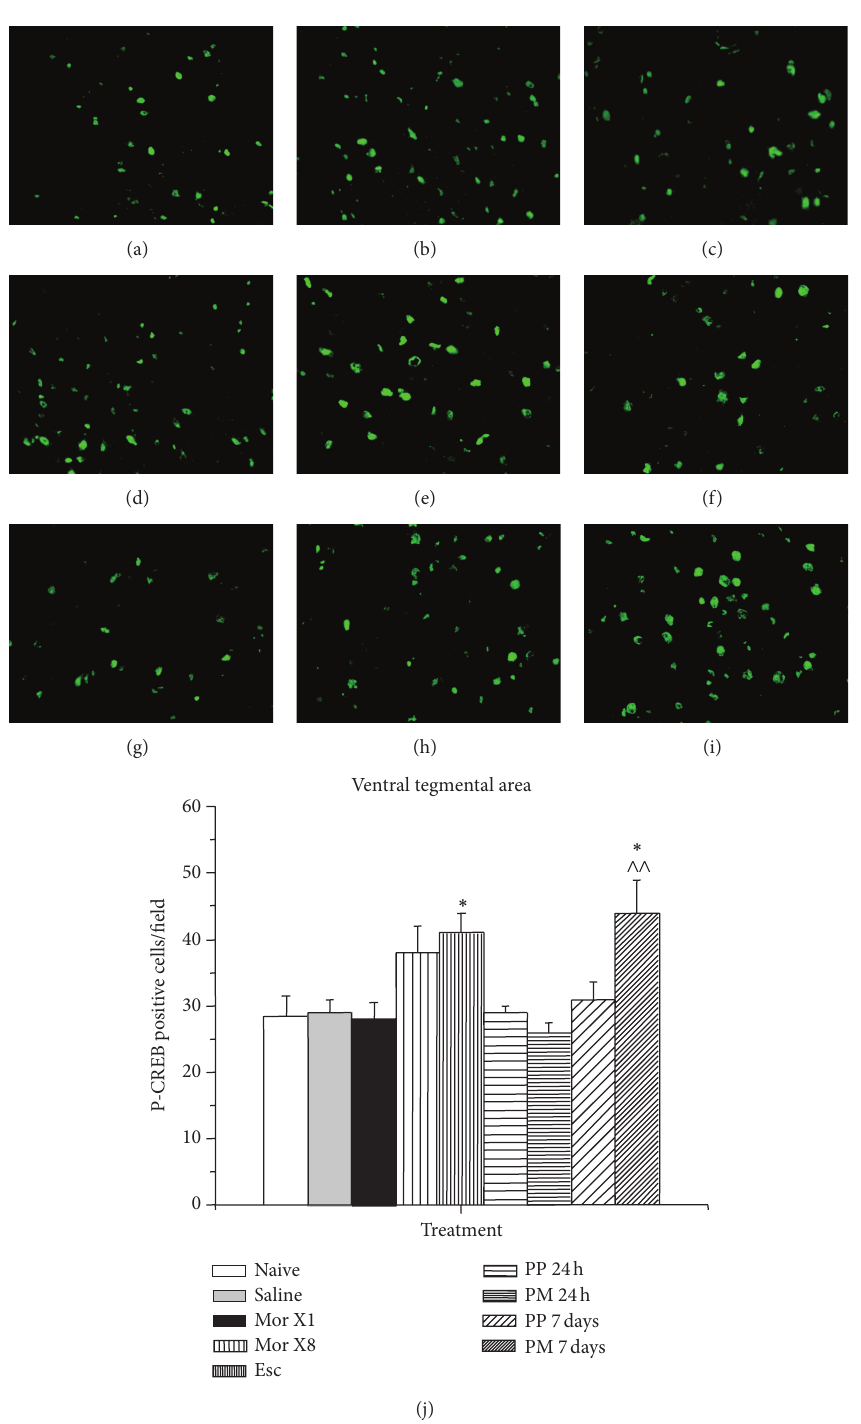
Figure 4: Changes in P-CREB staining in the VTA following different morphine treatments ((a) group 1, na¨ıve; (b) group 2, saline; (c) group 3, MorX1; (d) group 5, MorX8; (e) group 6, Esc; (f) group 7, PP24h; (g) group 8, PM24h; (h) group 9, PP7d; (i) group 10 PM7d) as determined by immunofluorescence (200X). Quantification of P-CREB (j). See Table 1 for details on the morphine treatment paradigm. 𝑁 = 6 – 9 per treatment. ∗ 𝑃 < 0.005 versus saline injection, ∗∗ 𝑃 < 0.0001 versus saline injection, ∧ 𝑃 < 0.05 versus 7 d placebo